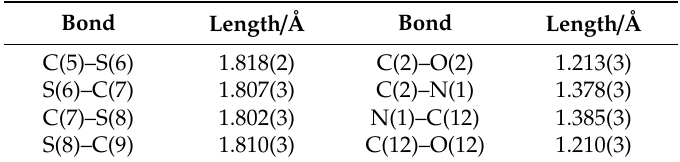
Figure 1. Two alternative views of the molecular structure of 1 with the numbering scheme used (thermal ellipsoids at 50% level). Table 1. Selected bond lengths.